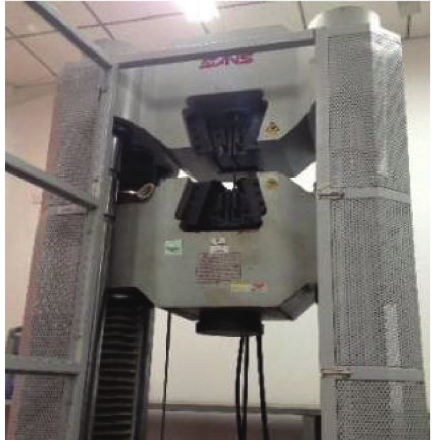
Figure 5: Loading equipment for the material test. R25